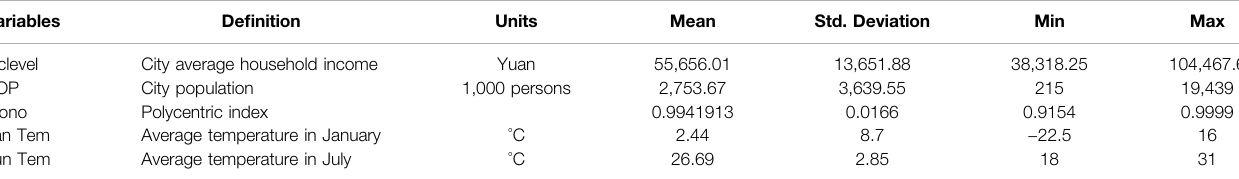
TABLE 2 | De fi nitions and descriptive statistics of city-level variables.